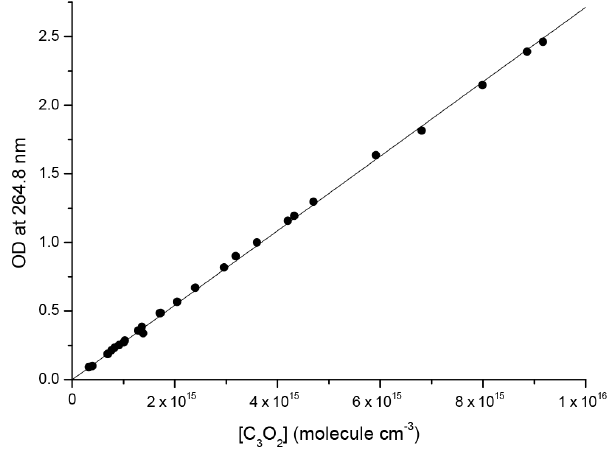
Figure 2. Beer–Lambert plot of optical density at 264.8nm versus [C 3 O 2 ]. The line is an unweighted proportional fit to the data with a slope of 2.71 × 10 − 16 nmcm 3 molecule − 1